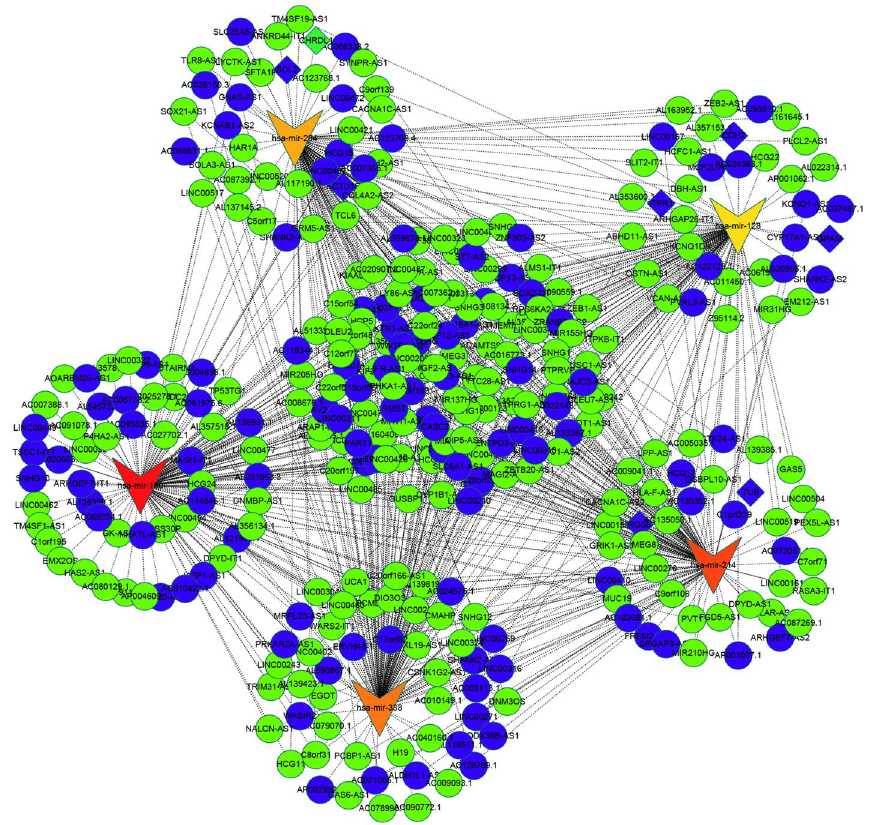
Figure 10. Construction of a ceRNA network. A ceRNA network consisting of 629 lncRNAs, 114 miRNAs and 980 mRNAs was constructed. The first five networks were then selected and defined as the hubnet. The circle represents lncRNA (adjusted < 0.05), the diamond represents mRNA (adjusted p < 0.05, logFC > 1, logFC < 0.05) and the triangle depicts miRNA (adjusted p <